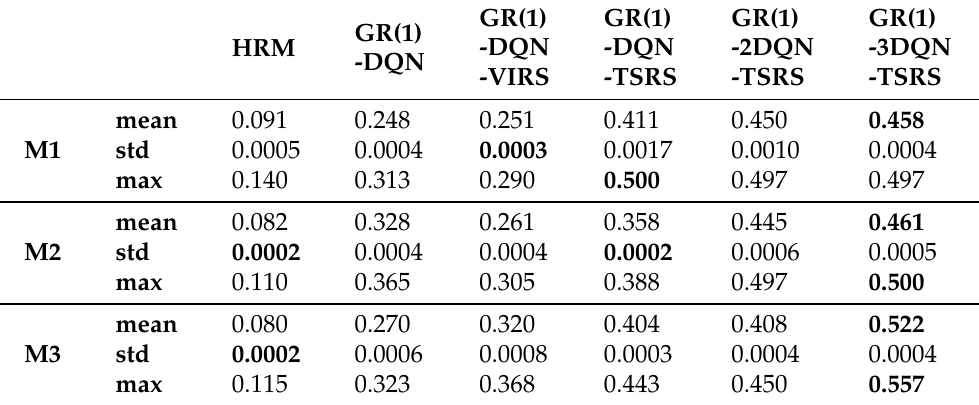
Table 3. The mean, max and standard deviation of learning curves from maps M1, M2 and M3 starting from training step